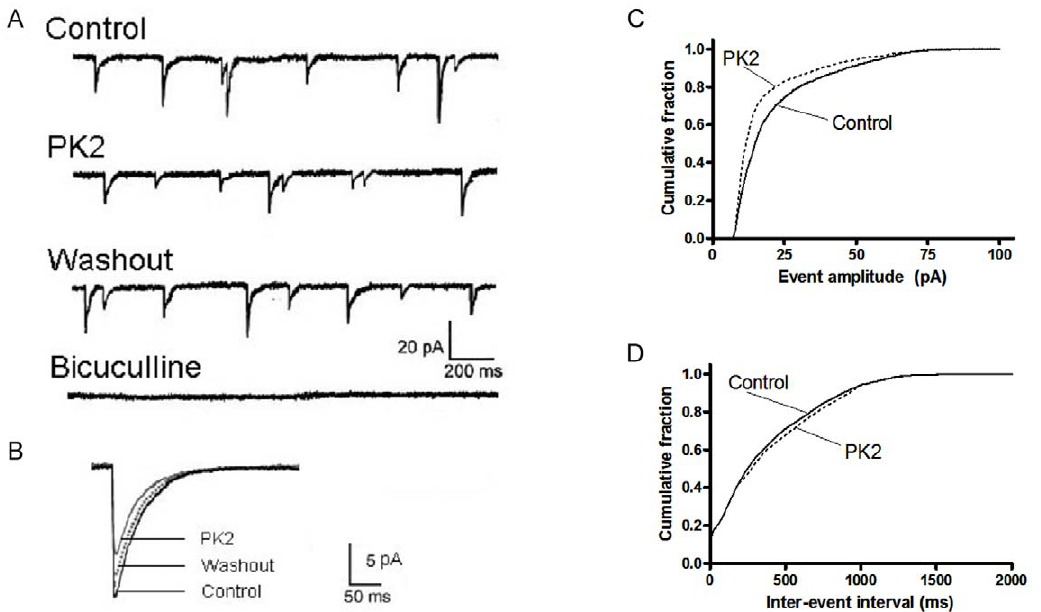
Figure 3. Effect of PK2 on GABA A receptor-mediated miniature inhibitory postsynaptic currents (mIPSCs) recorded from rat SCN neurons. (A) Representative current traces showing mIPSCs obtained under control conditions, during application of 0.1 nM PK2 and washout conditions. The slice was bathed in AP5 (50 m M), DNQX (10 m M), and TTX (1 m M). The holding potential was 2 70 mV. Bath application of 10 2 10 M PK2 for 10 min reduced the amplitudes of mIPSCs, but did not affect their frequency. During washout of PK2, there was a partial recovery of mIPSC amplitude. The mIPSCs were blocked by 30 m M bicuculline. (B) Average mIPSC waveforms of 300 randomly selected mIPSCs for each condition. (C, D) Cumulative event amplitude and inter-event interval plots for the neuron in A before and after PK2 application. PK2 caused a leftward shift in the amplitude but not interval distribution indicating that PK2 decreased the amplitude of mIPSC without altering the frequency.